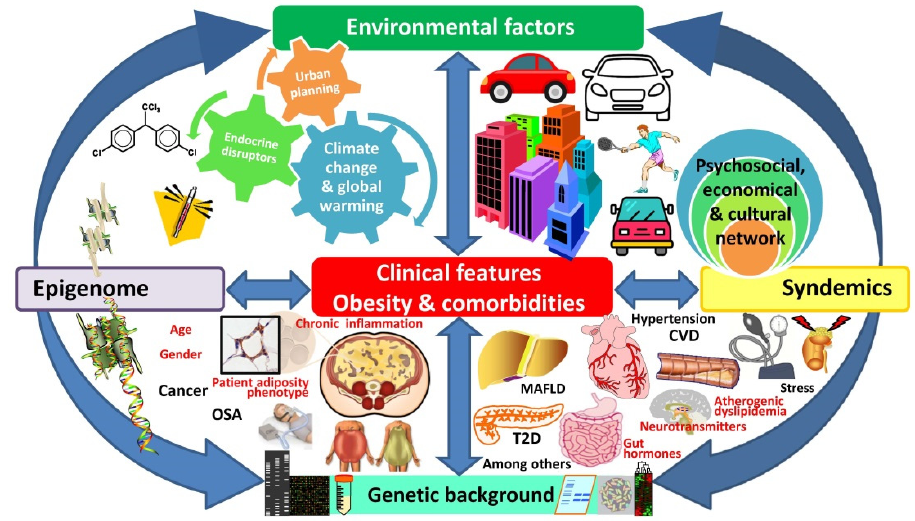
Figure 6. Multidimensional view of the complex interaction of the main drivers involved in excess weight development and obesity-associated comorbidities. OSA, obstructive sleep apnea; MAFLD, metabolic-associated fatty liver disease; T2D, type 2 diabetes; CVD, cardiovascular diseases.